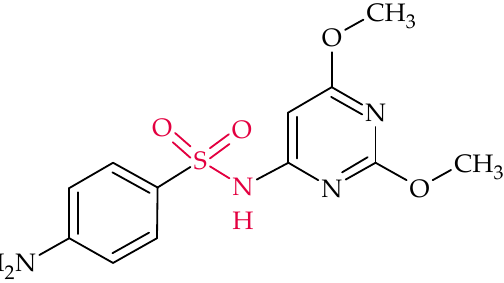
Figure 9. Chemical structure of sulfadimethoxine. The sulfonamide group is marked in red. Sulfadimethoxine